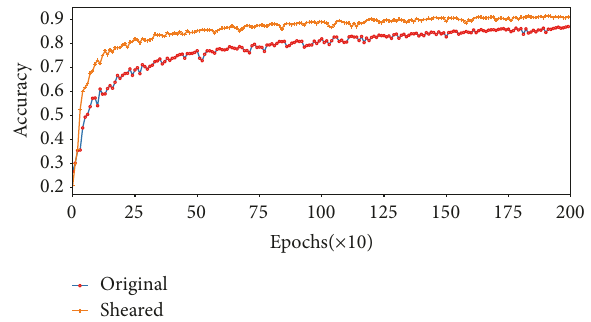
Figure 5: Comparison of training process between original and sheared.